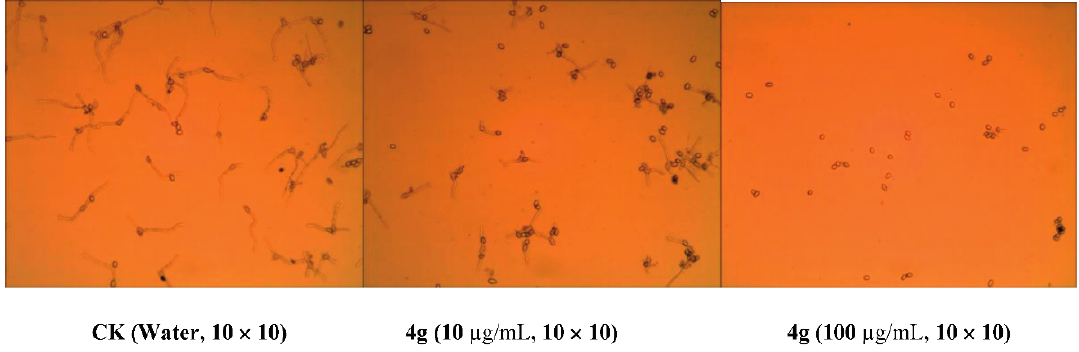
Figure 1. Inhibition of compound 4g against spore germination of B. cinerea . The pictures were taken from the fungi growing in the glass plates with a microscope with